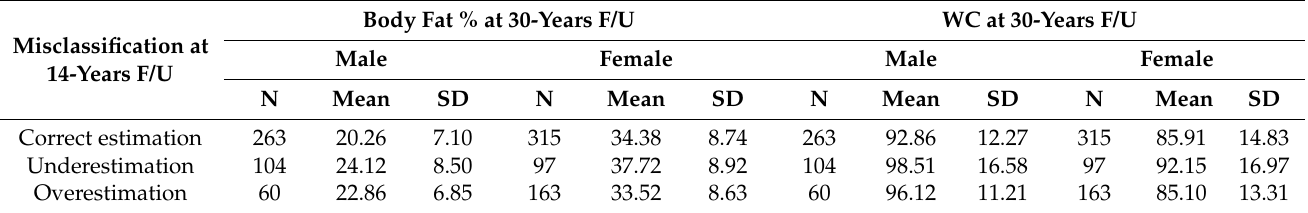
Table 1. Distribution of males’ and females’ body fat percentages and waist circumference at 30-year follow-up by body weight misclassifications at 14-year follow-up.